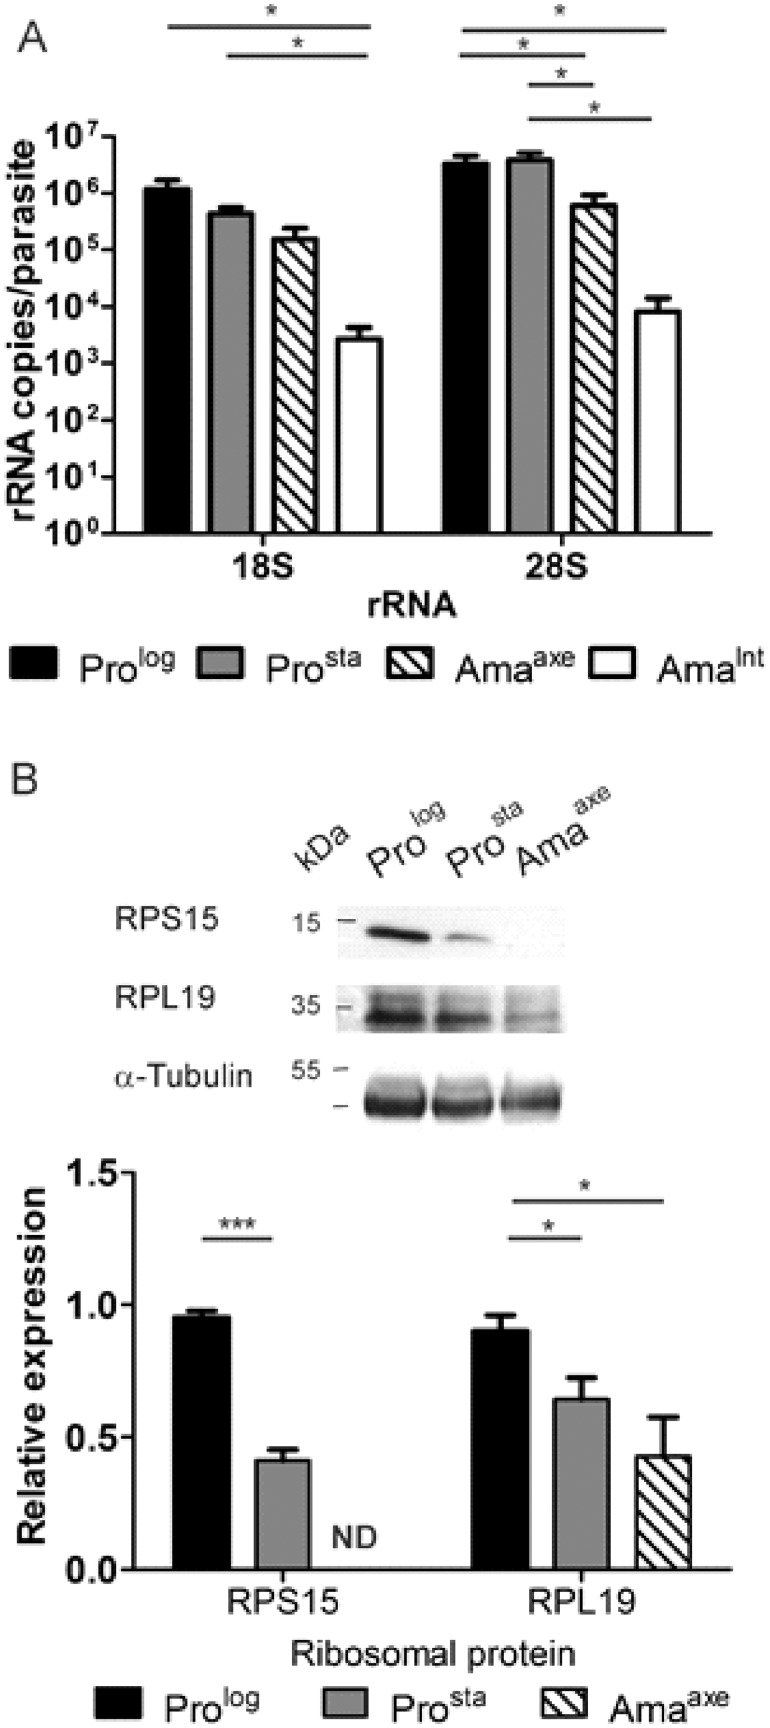
Decrease of rRNAs and ribosomal proteins in L. (V.) braziliensis amastigotes.A, Absolute quantification per parasite of rRNAs 18S and 28S α after reverse transcription and qPCR. The asterisks represent statistically significant differences between different pairs after performing multiple t-test. B, Evaluation of the expression of ribosomal proteins. The expression of RPS15 and RPL19 was normalized to the expression of α-tubulin and the results were rescaled to the expression on Prolog. The bars represent the mean ± SEM in three biological replicates. The number of asterisks represents different significance levels (* P ≤ 0.05 and ** P ≤ 0.01). ND, No bar is plotted because the expression of RPS15 in Amaaxe was below the detection limit.